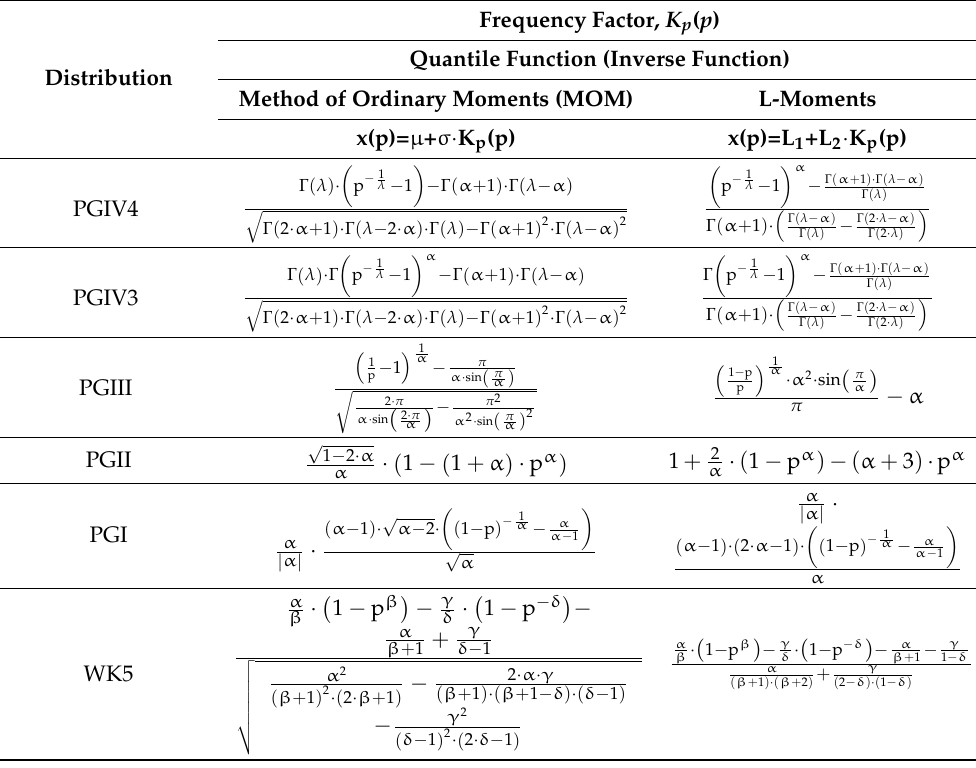
Table A1. Frequency factors.